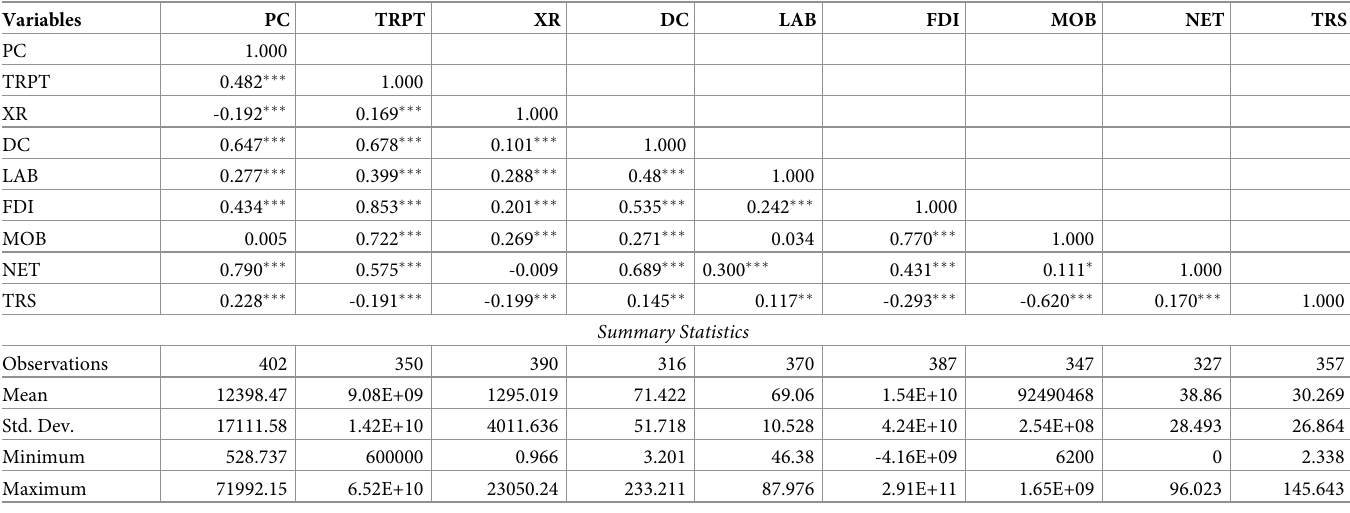
Table 2. Pairwise correlation analysis and summary